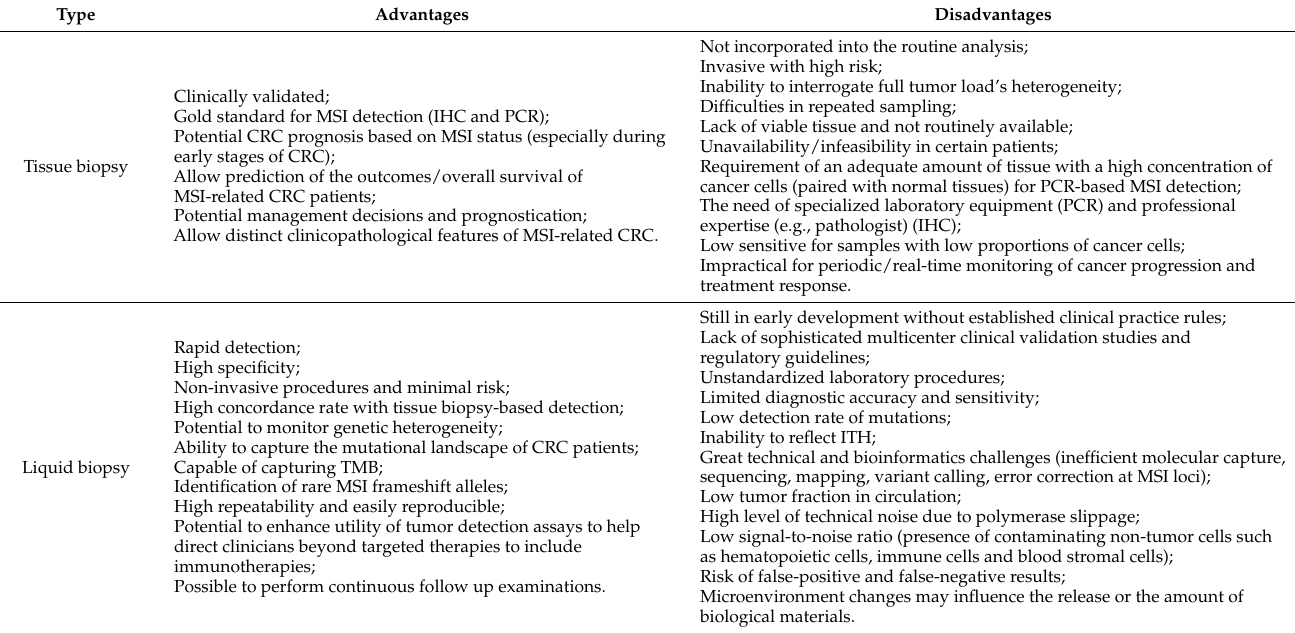
Table 2. Summary of pros and cons of MSI testing in tissue and liquid